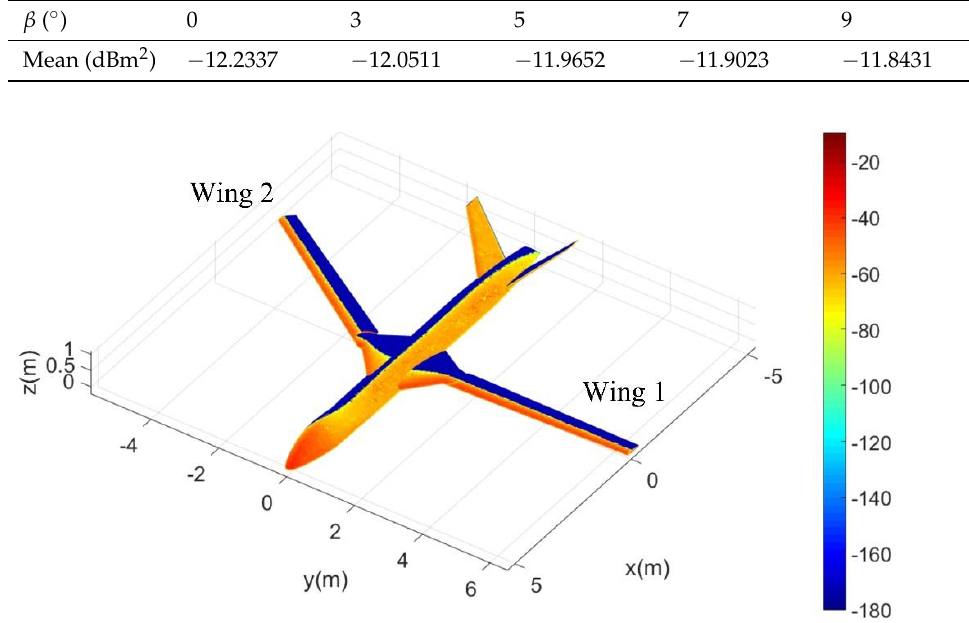
Figure 9. RCS of wing 1 under different sweepback angles, where α = 20° and F rh = 5 GHz. Table 5. RCS mean of wing 1, where α = 20°.